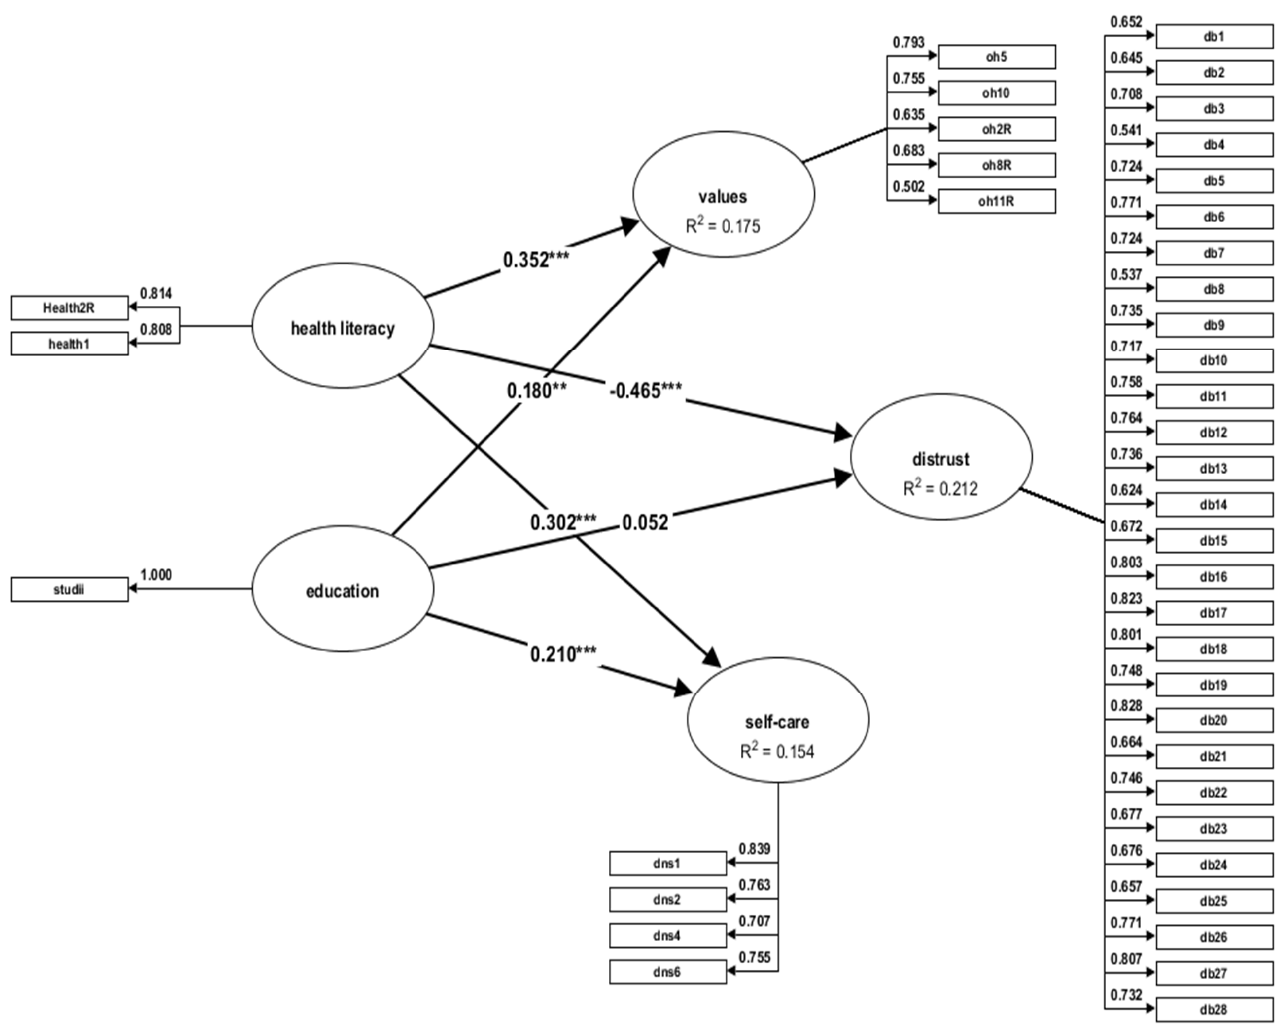
Figure 1. Structural equation model - male sample. ** p = 0.004; *** p = 0.000. Table 5. The inference of the effects of knowledge on values, attitudes, and behaviours on oral health; male sample (N = 250).